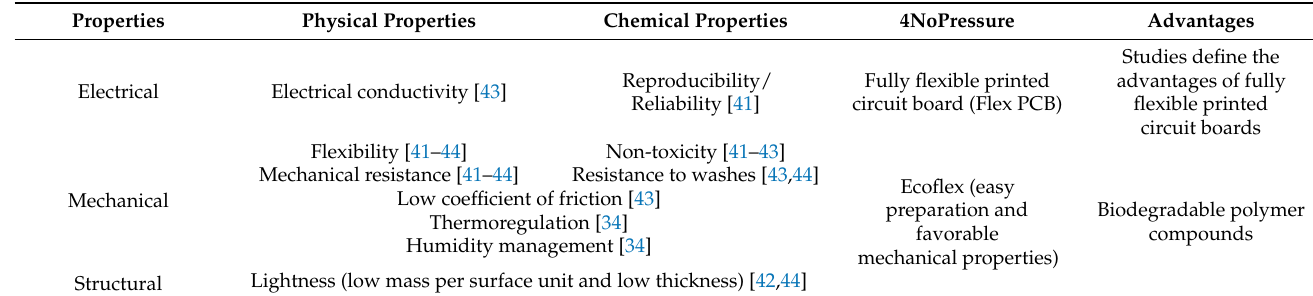
Table 5. Prototype characteristics of pressure, temperature, and humidity sensors to prevent pressure injury. Coimbra, Portugal,